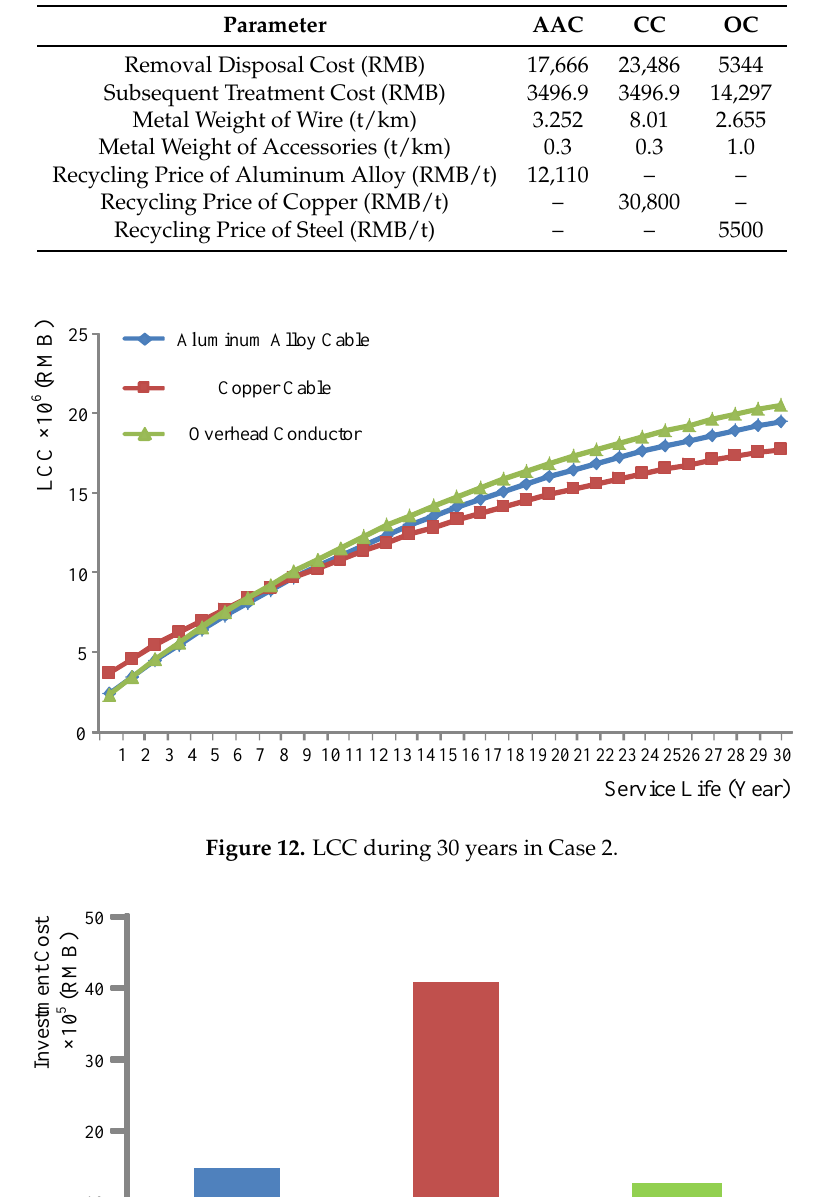
Table 10. Discard parameters in Case 2.